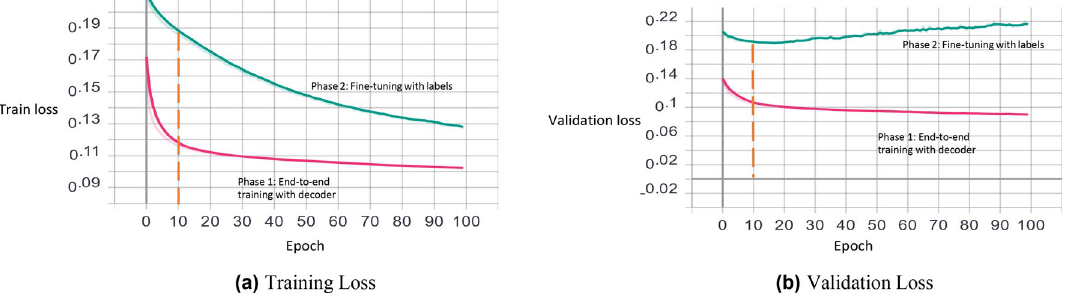
Figure 5. Visualization of training and validation loss in both phases (for the first fold). The weights of the 10th epoch, for both phases, are used in the experiments.